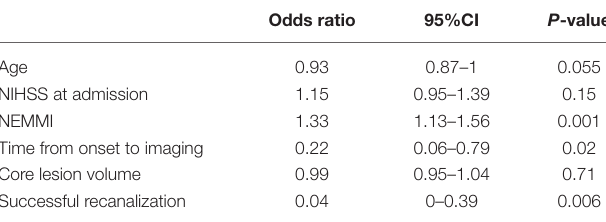
TABLE 2 | Multivariable logistic regression analysis for risk analysis of MMI.